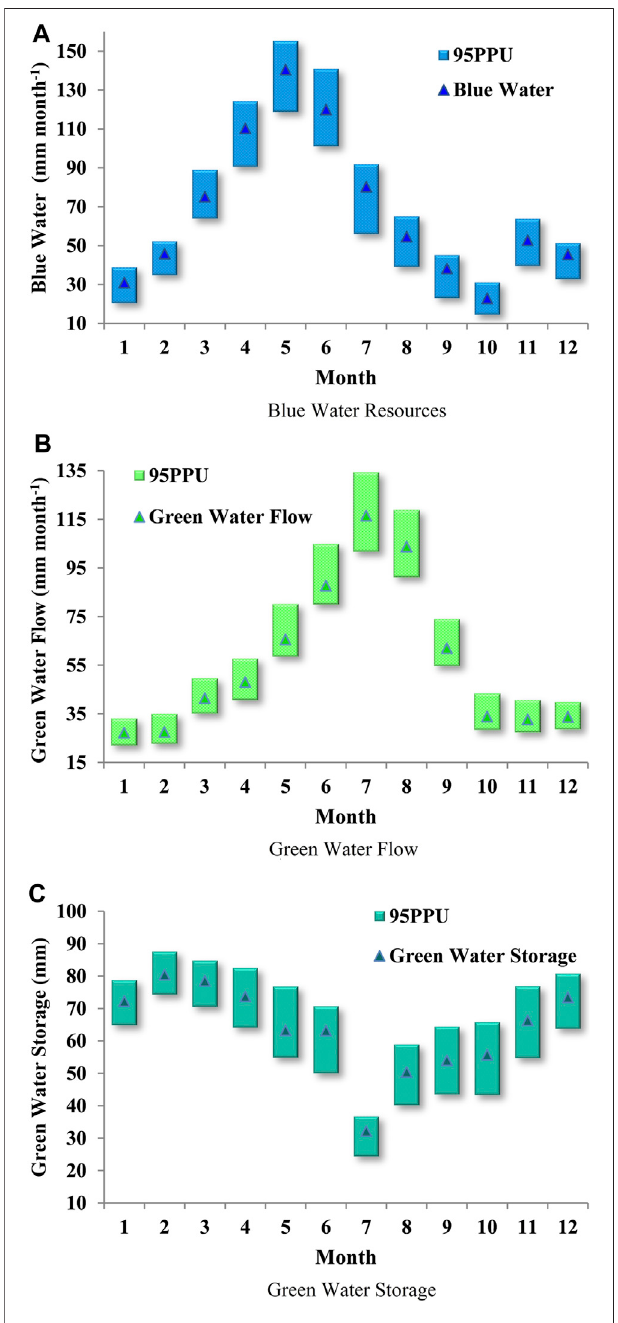
FIGURE 8 | Distributions of the monthly average (A) blue water resources, (B) greenwater fl ow, and (C) green water storage simulatedunder historical climate scenario A (1996 – 2015) in the Xiangjiang River